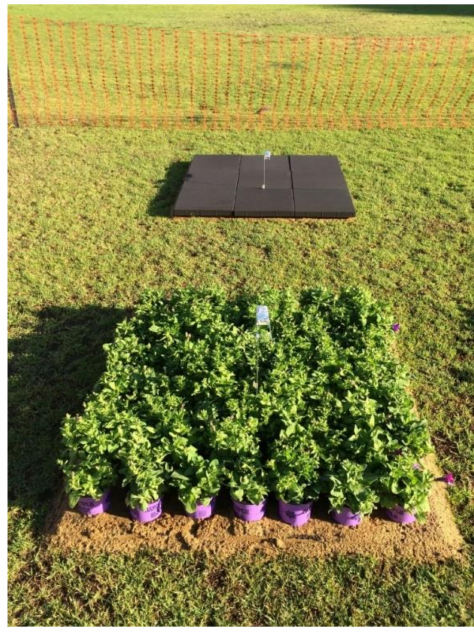
Figure 6. Ground cover (non-native, petunias) ( Petunia × hybrid ) and pavers (grey), on a bed of yellow